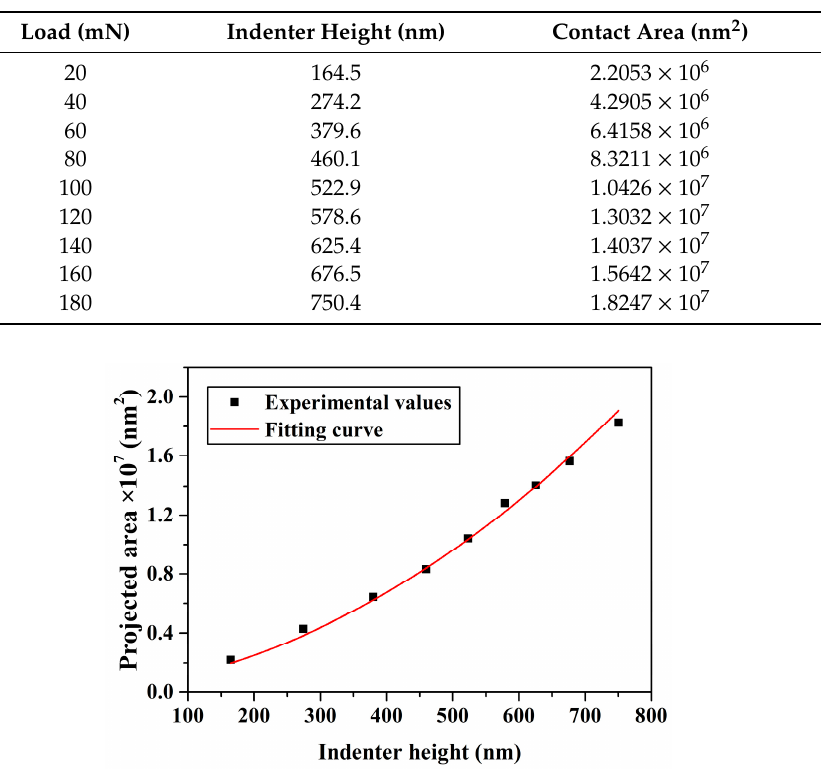
Table 2. Indenter height and contact area for di ff erent loads.